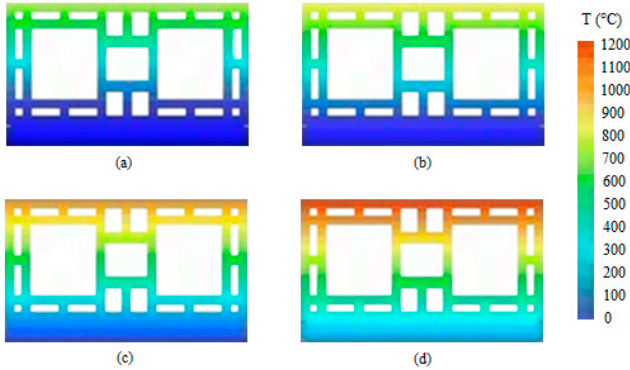
Figure 6. Temperature distribution at ( a ) 30 min, ( b ) 60 min, ( c ) 120 min, and ( d ) 240 min.